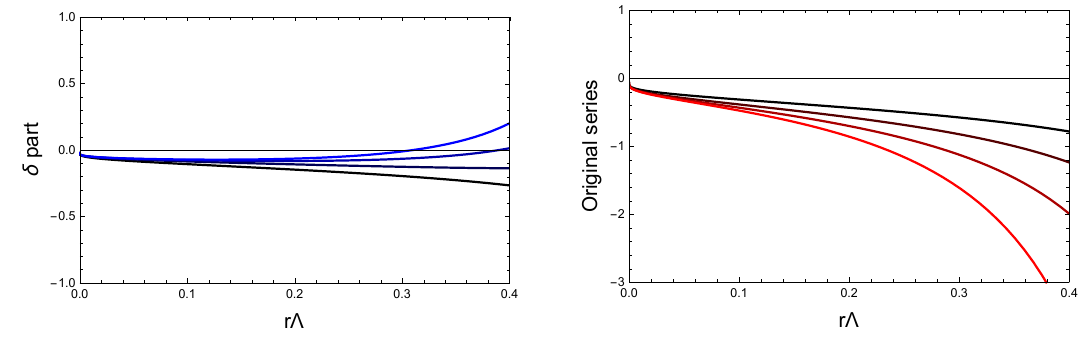
Figure 12 . Perturbative series of the (cid:14) part for the dimensionless potential (left). This is compared to the original series containing renormalons (right). Deeper blue (red) line corresponds to higher order result. The highest order is O ( (cid:11) 4 ). s